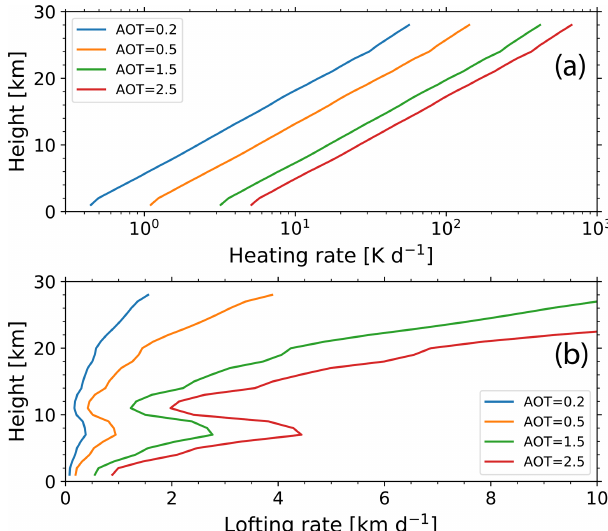
Figure 7. ECRAD simulations of (a) heating rate and (b) corre- sponding lofting rate as a function of height for four different AOTs of a 2km thick smoke layer. The center height is stepwise increased by 1km in the simulation from 1 to 28km height. The Punta Arenas temperature gradient profile in Fig. 5 is used. Daily average heating and lofting rates are